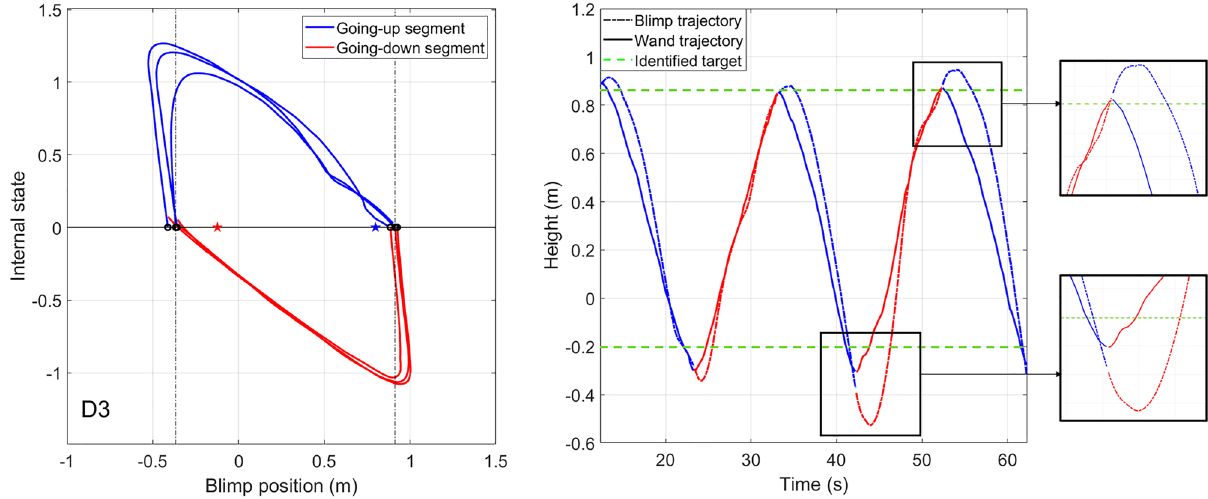
Figure 5. ( Left ): The internal state trajectory (dataset 3). Black circles show the initial state of the system. The blue and red straight lines are the equilibrium set of the going-up/down segments. The identified target position of the going-up/down segments is shown by the blue/red star. ( Right ): Blimp and wand trajectory. As shown in the zoomed-in plot, after the human stops moving the wand and switch the target position, the blimp takes additional time to change its direction. This results in the “wrong”initial response of the closed-loop